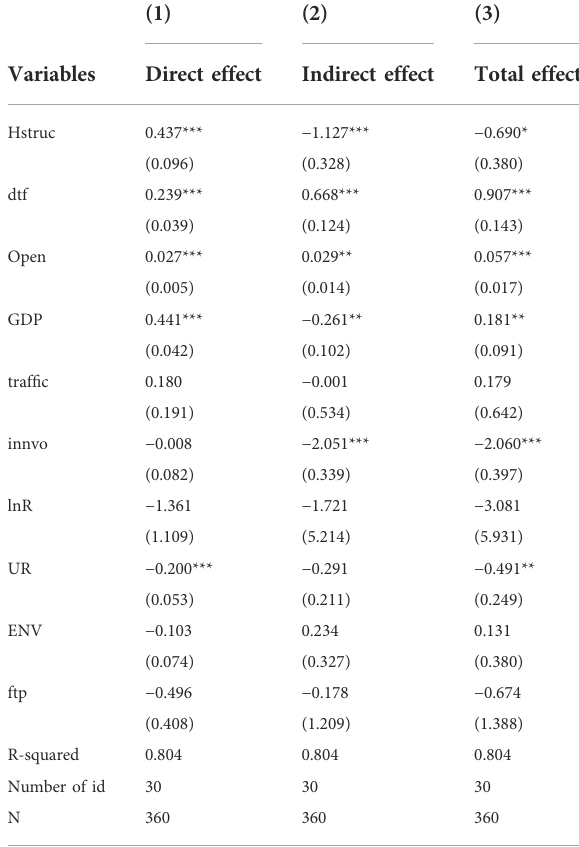
TABLE 10 Decomposed results of spatial